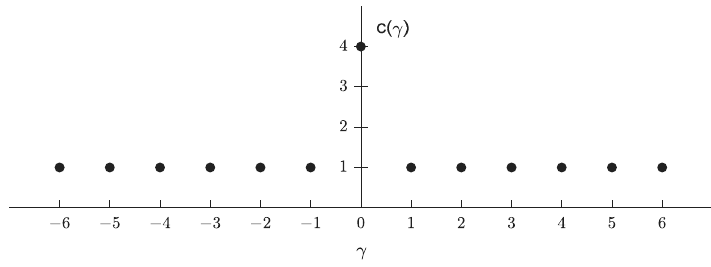
Figure 9. Co-array for the MRA when N =